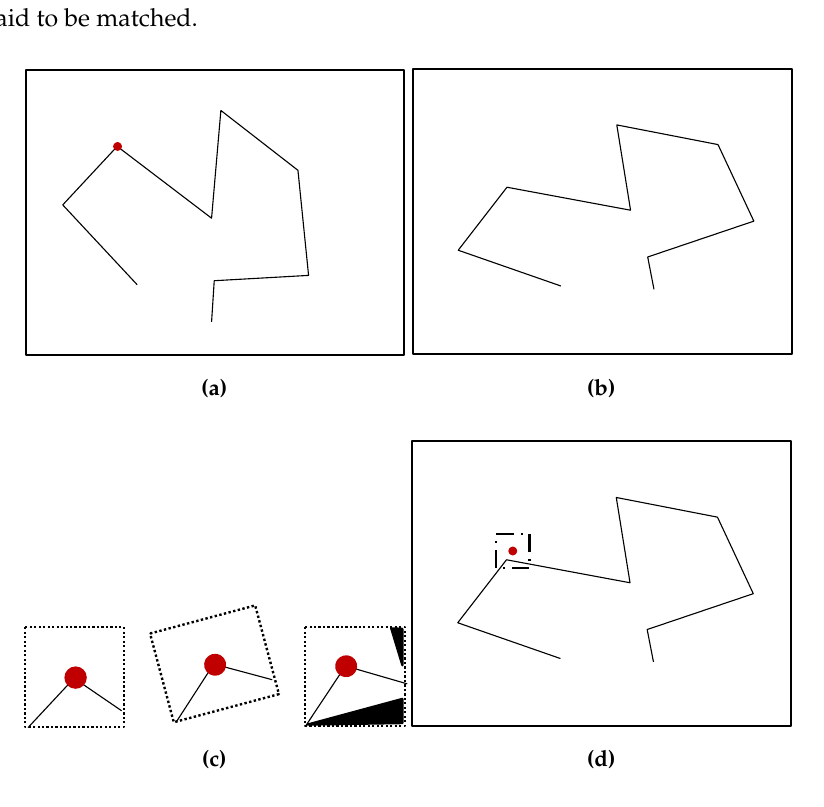
Figure 6. Point matching process. ( a ) Frame captured at camera pose C 0 , where point x was initialized; ( b ) frame captured at camera pose C i , where point x is intended to be matched; ( c ) patch warping process, showing the original, the transformed and the cropped patches; ( d ) projection of landmark point x into image point u i on the image at camera pose C i . The search area is indicated by the rectangle surrounding the